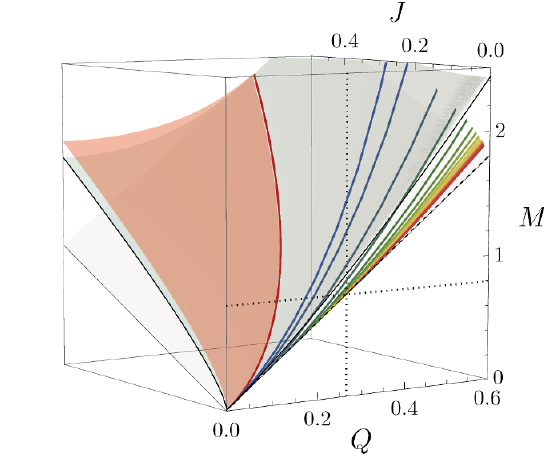
Figure 14 . A 3D solution space of the hairy black holes. The CLP black holes exist above the dark gray plane, and intersect the BPS limit M = 3 Q + 2 J (the white plane below) at the Gutowski- Reall family (red bold line). The orange plane is the CLP solutions with (cid:10) H = 1, below which the solutions have (cid:10) H > 1. The solid bold lines in rainbow are the hairy solutions with (cid:12)xed horizon velocity (cid:10) H = 0 : 4, and (cid:12)xed horizon scalar value " H . The (cid:12)rst line in blue is the merger line for the constant (cid:10) H = 0 : 4, and exists just above the extremal plane. The dotted black gridlines on the front right face show the special soliton with Q c ’ 0 :